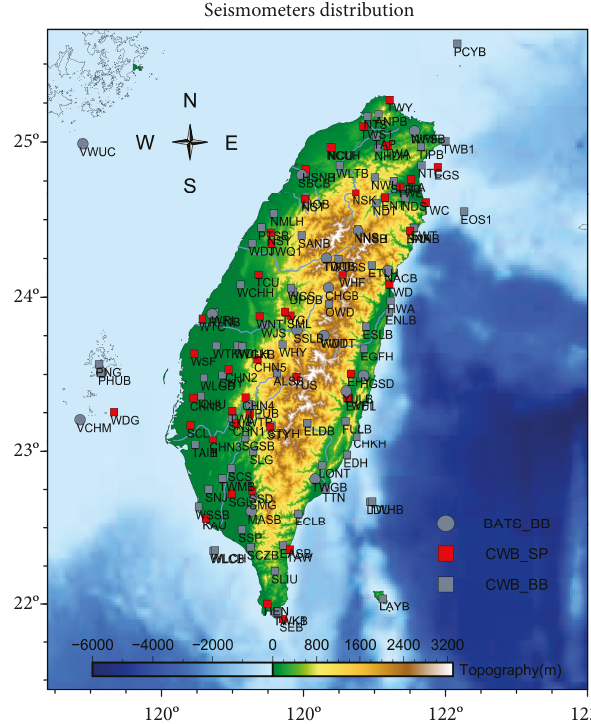
Figure 1: Distributions of broadband (gray symbols) and short- period (red squares) stations in Taiwan. The background color shows regional topography and